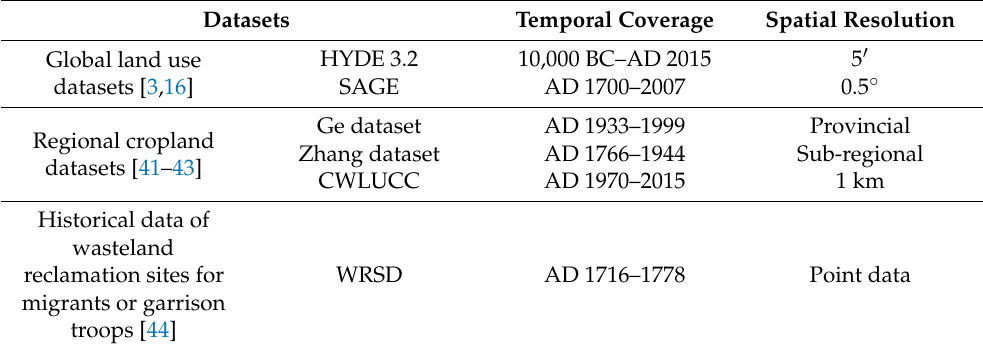
Table 1. Global historical cropland datasets and regional cropland data in Xinjiang area of China. Datasets Temporal Coverage Spatial